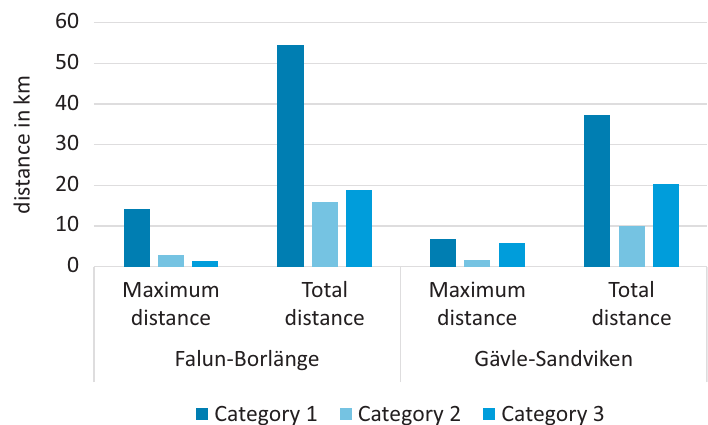
Figure 3. Maximum distance and total distance travelled by area category and region. Note: Data from 28 March